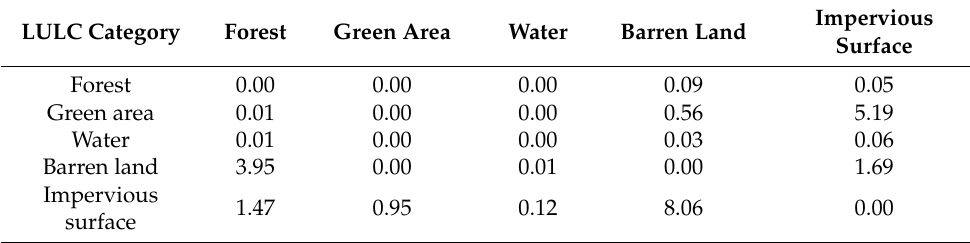
Table 18. Contribution of LULC categories to change 2030–2050